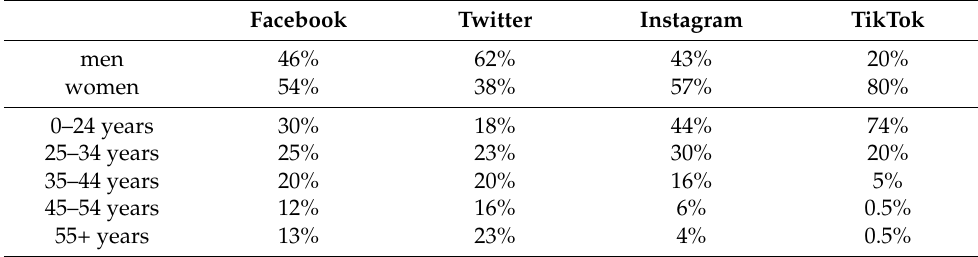
Table 4. Gender and age of Polish social media